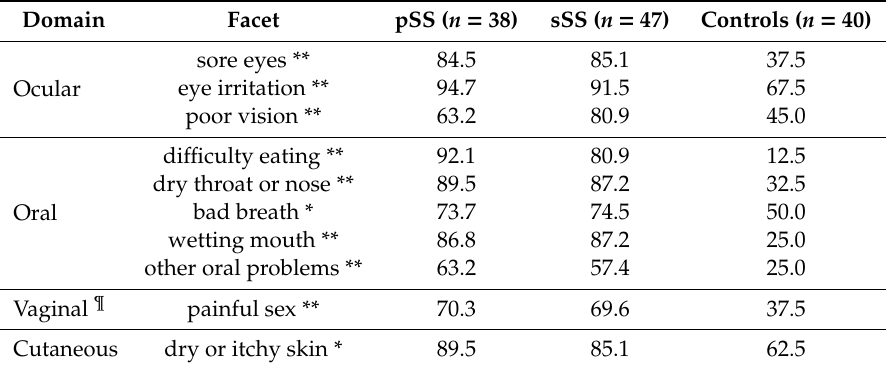
Table 2. Prevalence (%) of sicca